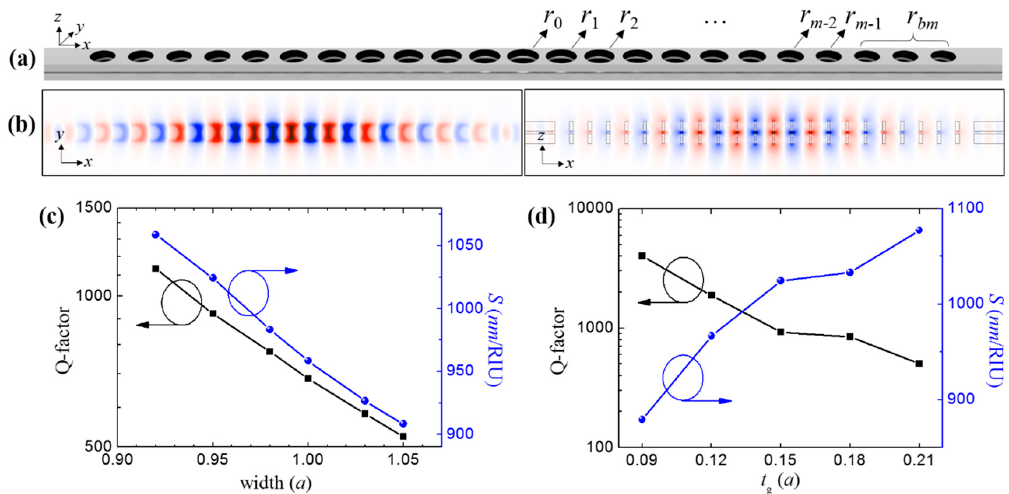
Figure 2. Optimization of the waveguide structure of a PhC NB cavity for refractive index sensing. ( a ) Schematics of the PhC NB cavity structure with a horizontal air gap; ( b ) x–y and x–z cut-views of E z field distribution of the air gap cavity mode when width w = 0.95 a , thickness of air gap t g = 0.15 a , and size variation of air holes Δ r / r 0 = 0.10; Q-factor (black square) and sensitivity S (nm/ RIU ) (blue circle) as a function of ( c ) width ( w ) of the PhC NB and ( d ) thickness ( t g ) of the air gap.